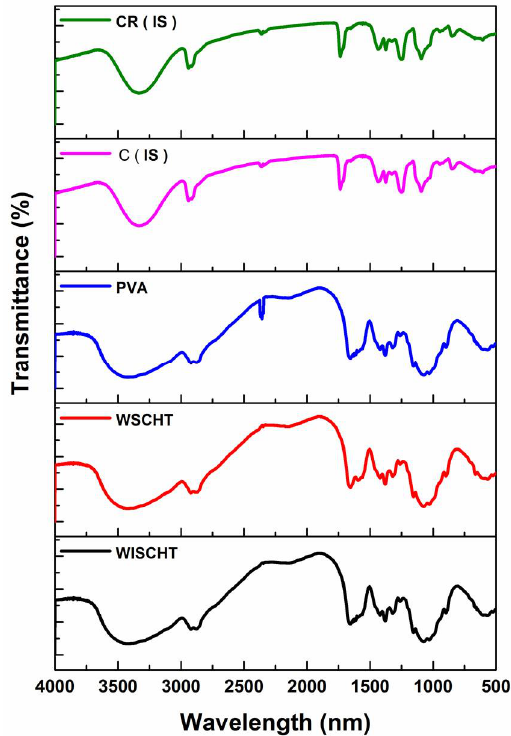
Figure 4. Fourier transform spectroscopy (FT-IR) spectra of prepared samples.